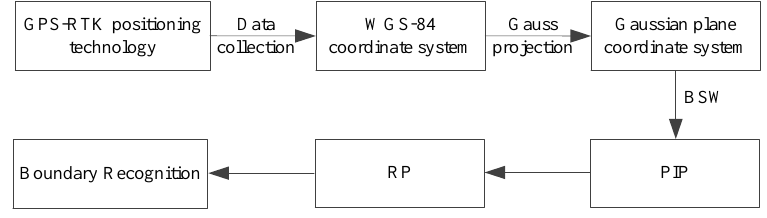
Figure 3. Flowchart of Pavement Construction Area (PCA) boundary recognition.